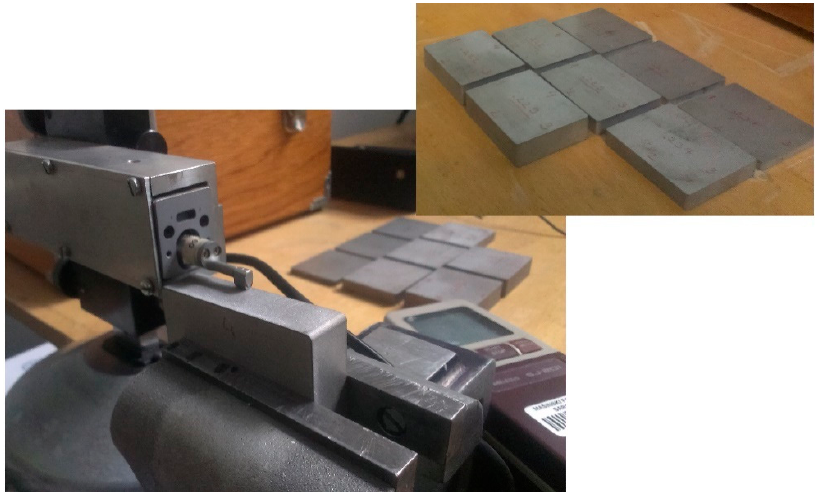
Figure 1. The sample to measure surface roughness with the measuring equipment. The Ra was used to evaluate the surface roughness; it is one of the most-studied AWJ process parameters in research and industry. The surface roughness was measured at three different sections in the jet direction (top, middle, and bottom), as shown in Figure 2. The roughness was measured at four locations (P1, P2, P3, and P4) along the length of the cut surface, as shown in Figure